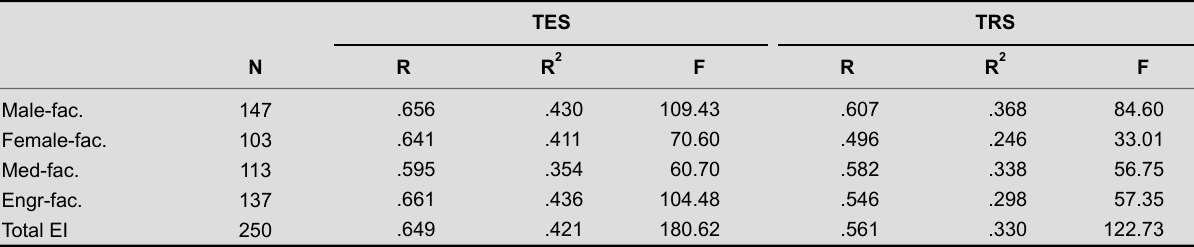
Regression of EI on TES and TRS